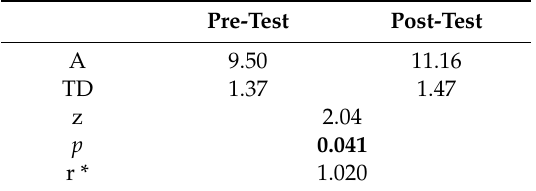
Table 11. Average (A), typical deviations (TD), Wilcoxon test results (Z), significance ( p ), and dMR value (r) of the total number of students in the pre-test and post-test in the self-awareness rest.